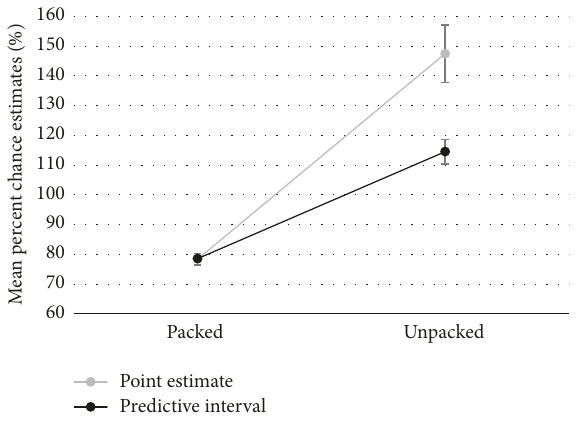
Figure 9: The mean percent chance estimate by participants for events within the boundary values of the predictive interval by point estimate and predictive interval conditions plotted over whether a single question (packed) or four separate questions (unpacked) were asked in Experiment